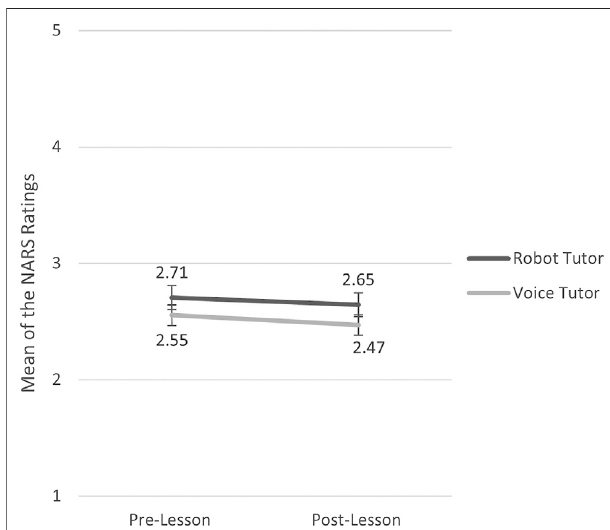
FIGURE 4 | Mean of the NARS ratings in the robot tutor and voice tutor conditions before and after the lesson. N (cid:1) 100 for the pre-lesson NARS; N (cid:1) 99 for the post-lesson NARS. The highest possible score for each test was 5. The error bars indicate the standard errors.